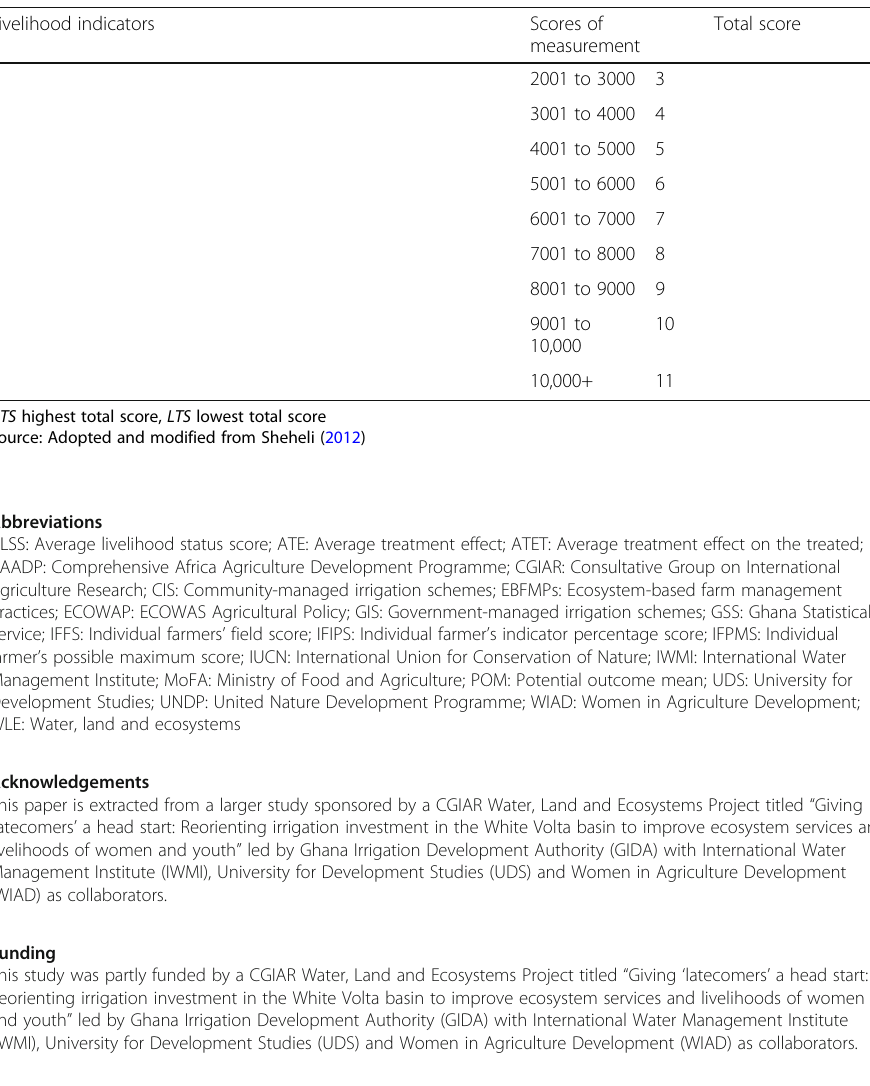
Table 8 Livelihood indicators of farmers and scores of measurements (Continued) Livelihood indicators Scores of